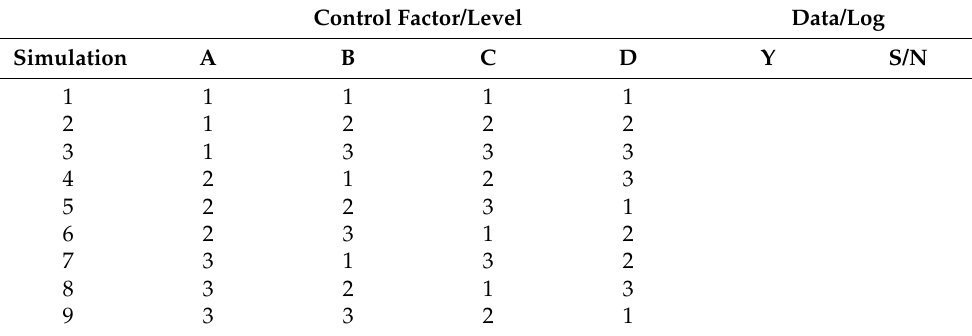
Table 3. L 9 (3 4 ) orthogonal array.